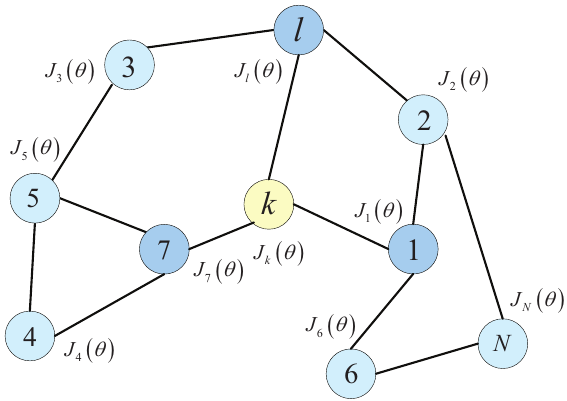
Figure 3. The topology of IWSN with N intelligent